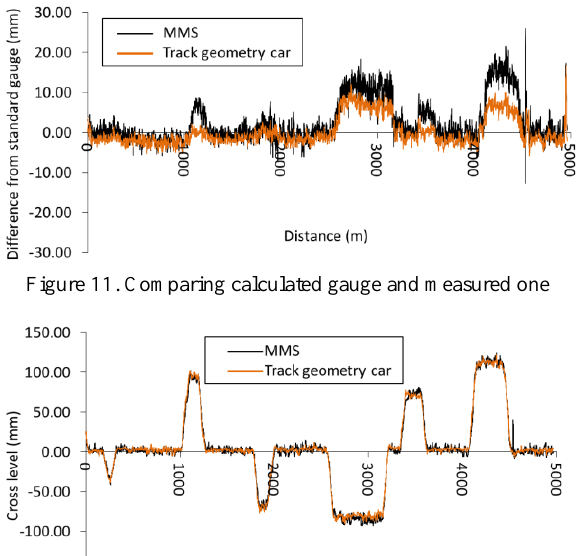
Figure 12. Comparing calculated cross level and measured one Gap between calculated values by MMS and measured values by special car Standard deviation Table 2. Result of the gap of gauge and cross